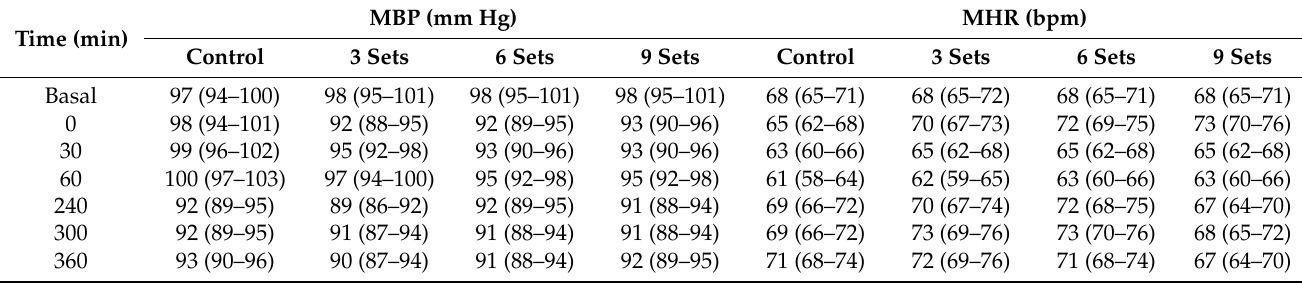
Table 3. Basal and post-exercise interventions on MBP and MHR. Least square means (95% CI).